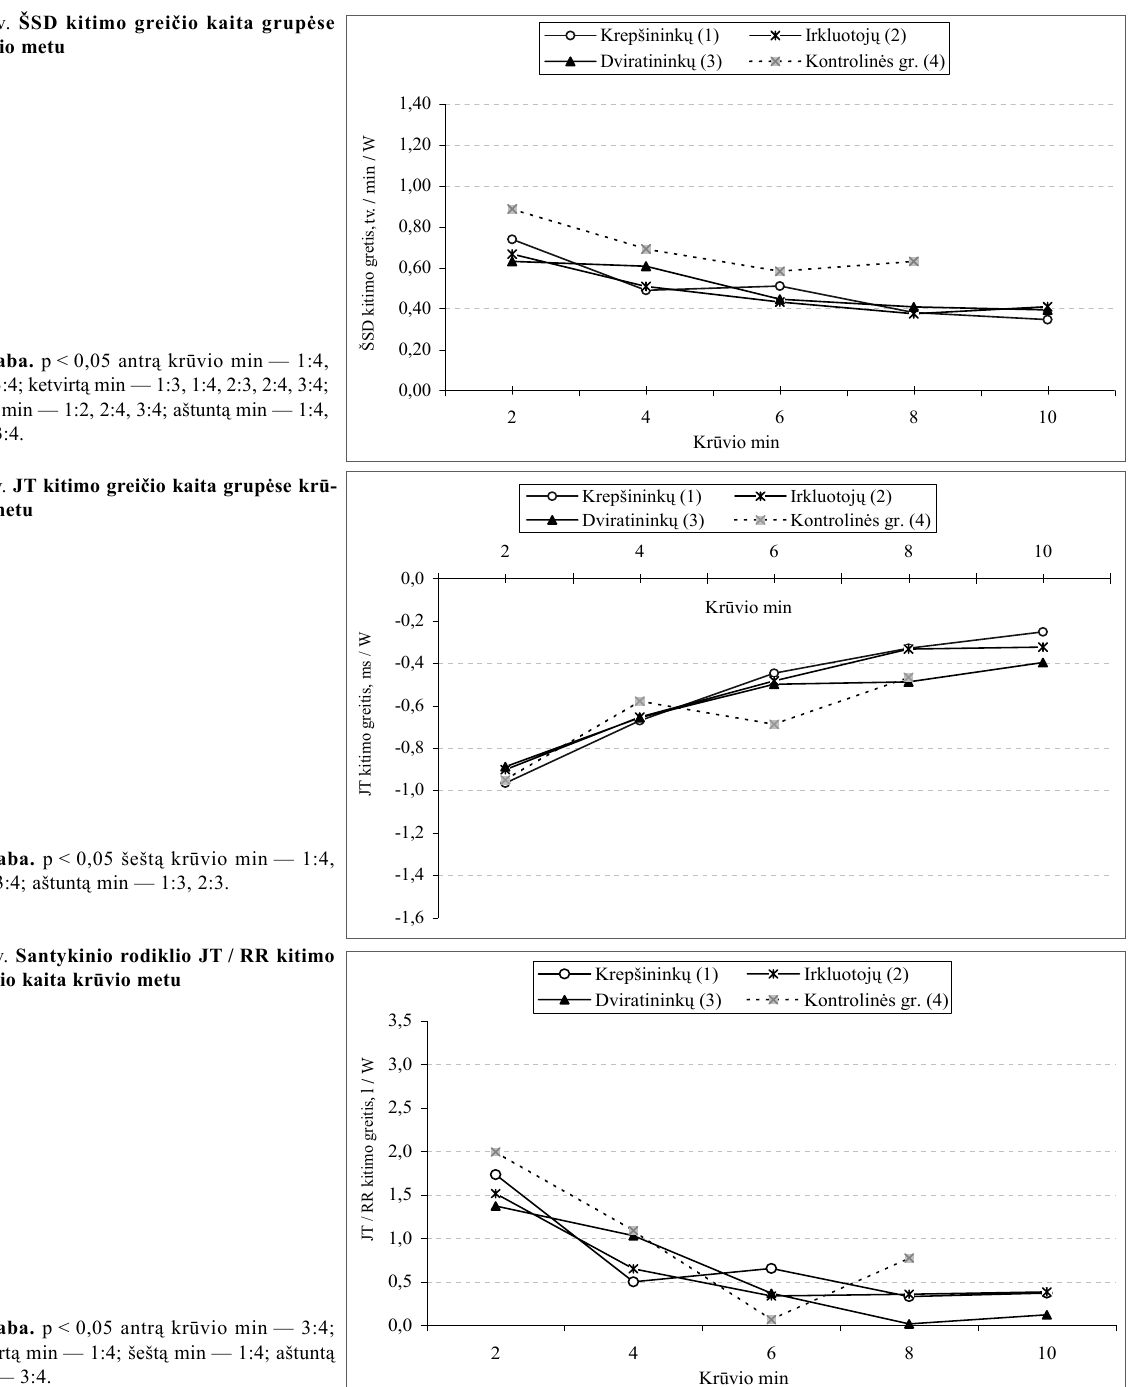
min — mažiausias, o nuo šeštos iki aštuntos — did ė ja. Antr ą , šešt ą ir aštunt ą minut ę išryšk ė ja statistiškai reikšmingas skirtumas tarp kontrolin ė s grup ė s ti- riam ų j ų ir sportuojan č i ų j ų rodikli ų (p < 0,05). 5 paveiksle pateikti (S-D) kitimo grei č io duo- menys. Nustatyta, kad dviratinink ų ir irkluotoj ų (S-D) kitimo greitis panašus: iki šeštos minut ė s kinta nedaug, nuo šeštos iki dešimtos — tolygiai maž ė ja. Krepšinink ų šio rodiklio greitis iki aštun- tos minut ė s maž ė ja tolygiai, aštunt ą minut ę pasie- kia mažiausi ą reikšm ę , nuo aštuntos iki dešimtos